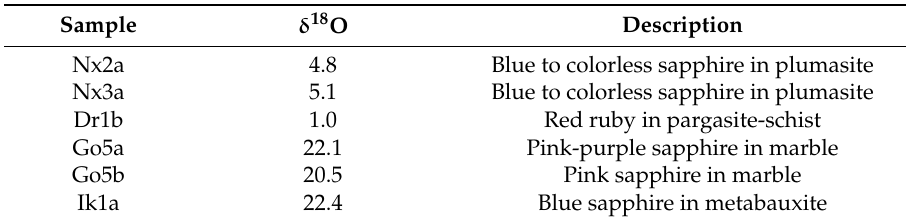
Table 6. Oxygen isotope values of corundum from Greece. δ 18 O corundum ( ‰ , V-SMOW) (after Wang et al. [83]).